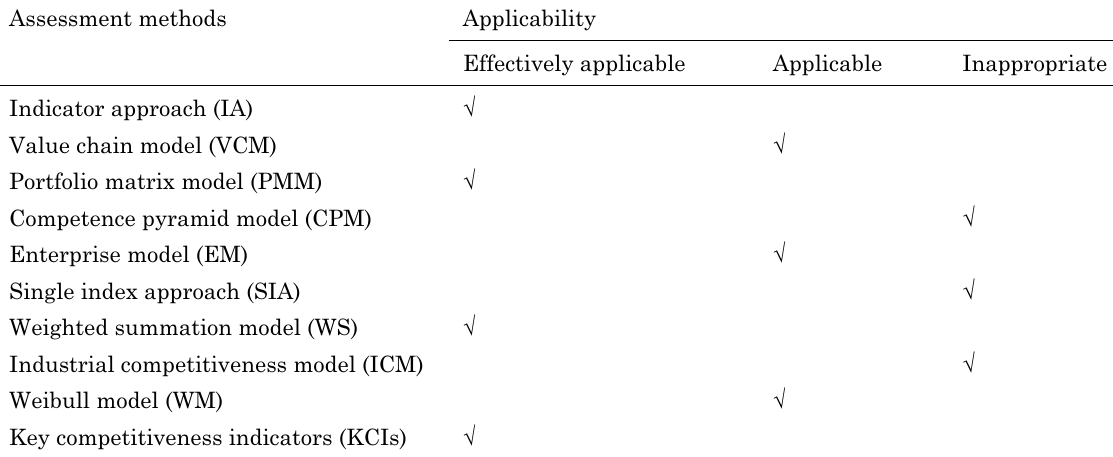
Table 2. Summary on the applicability of competitiveness assessment methods for REEs Assessment